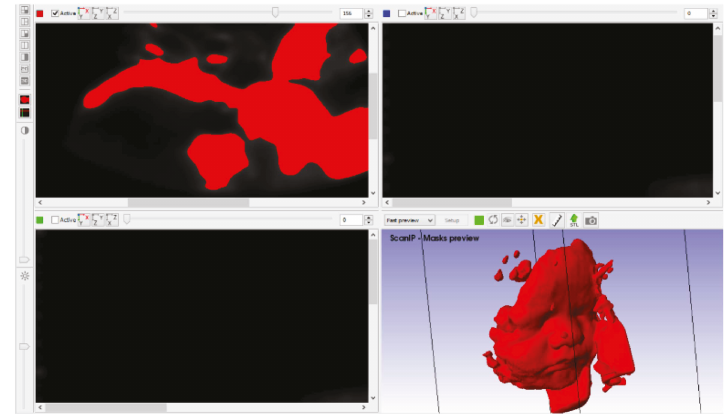
Figure 4: Steps of segmentation process.